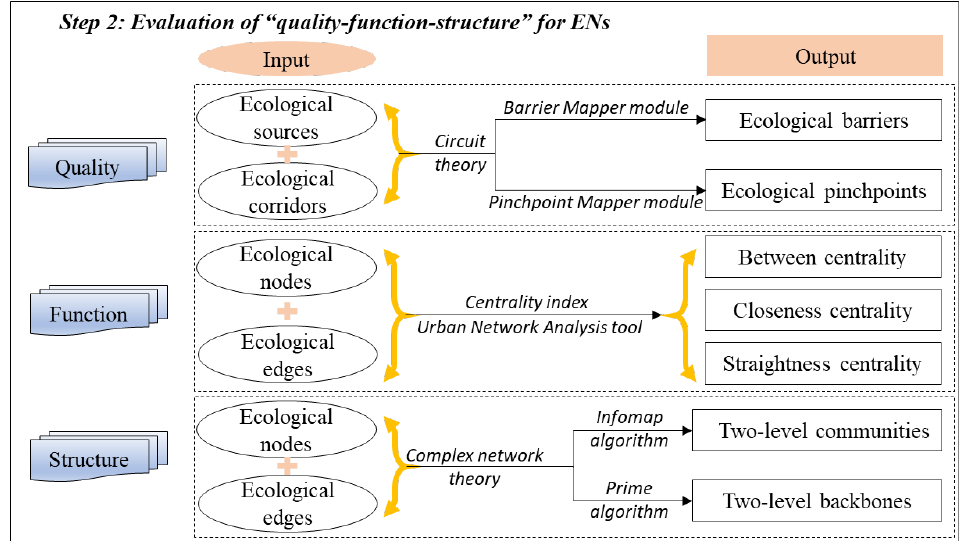
Figure 3. Evaluation of “quality– function –structure” for ENs in WUA.